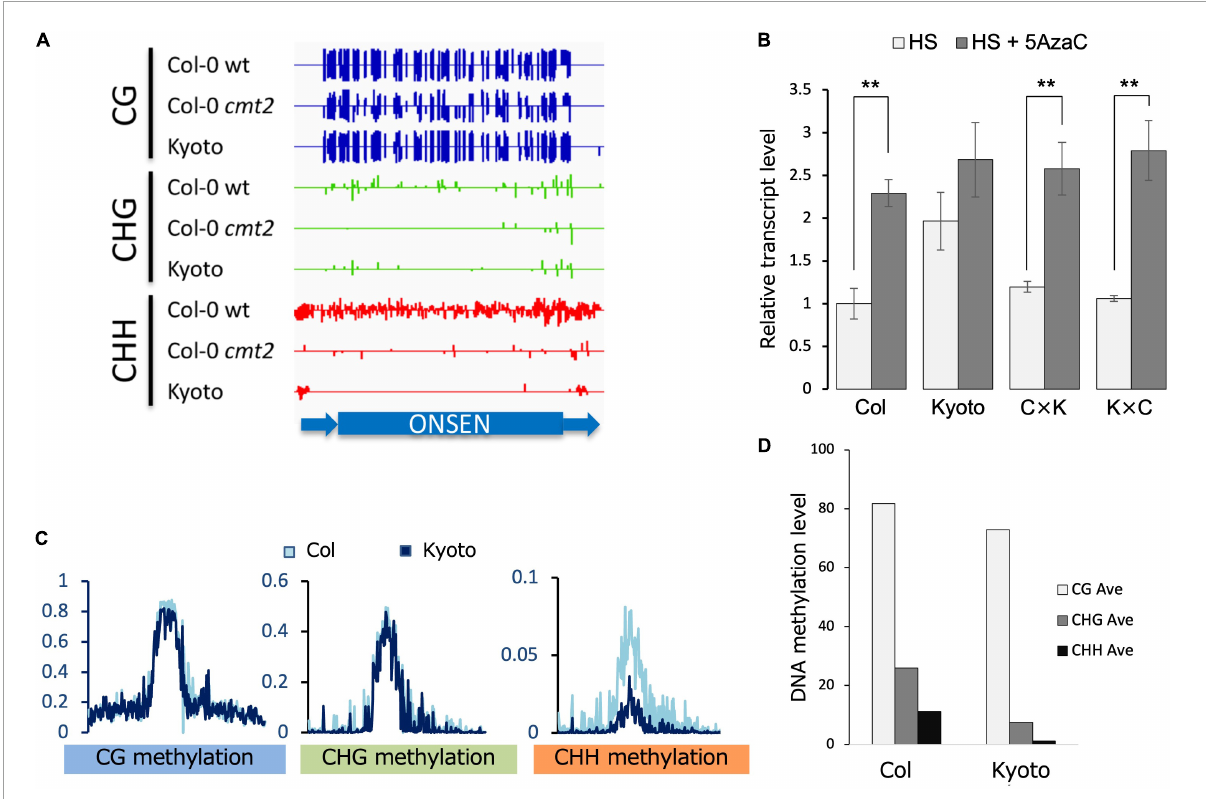
FIGURE3 Transcription and methylation analyses. (A) DNA methylation in ONSEN sequences of Col-0, cmt2 , and Kyoto. In the random mapping, the non-unique reads are mapped with reads evenly distributed among each copy, which is indicative of ONSEN ’s overall methylation trend. (B) Transcript levels of ONSEN under heat stress (HS) and 5-aza-2’-deoxycytidine (5AzaC) treatment. Values represent means ± SD from three biological replicates. Asterisks mark statistically significant differences. (C) Genome-wide DNA methylation levels of transposable elements on NS. (D) Average ONSEN DNA methylation levels on